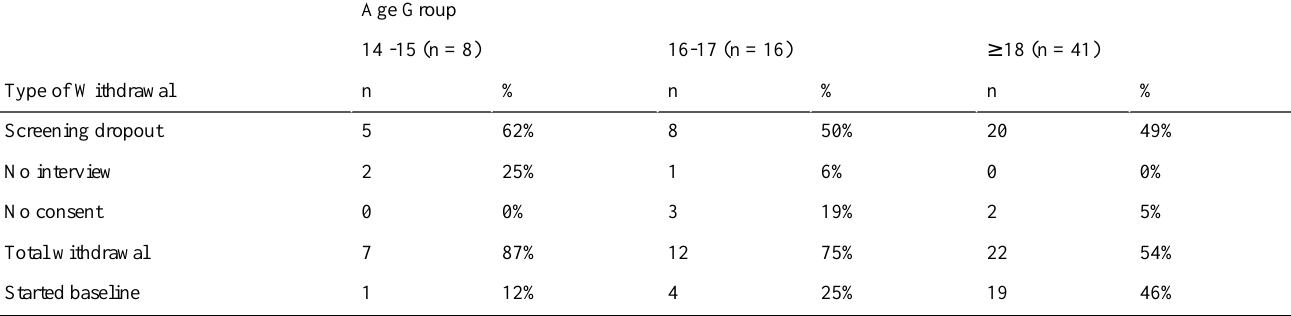
Table 1. Type of withdrawal by age group of applicants who were not excluded